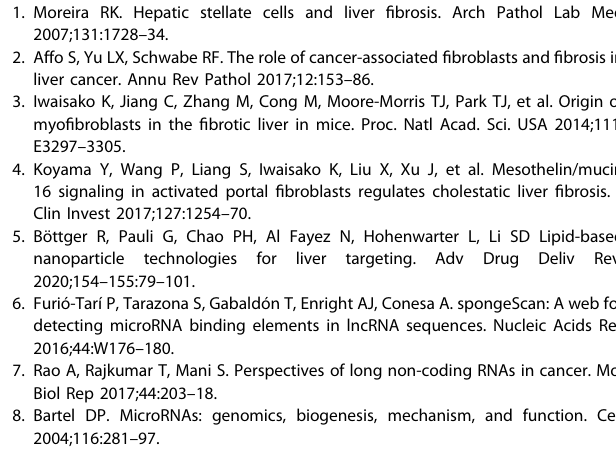
Fig. 8 Downregulation of NEAT1 and overexpression of miR-139-5p suppressed the expression of pro fi brotic markers in murine fi brosis models. A The liver tissues from fi brotic mice injected with Ad-Con or Ad-shNEAT1 were treated with immunohistochemical staining, n = 6 mice for each group, original magni fi cation × 200. B The liver tissues from fi brotic mice injected with agomir control or ago-miR-139-5p were treated with immunohistochemical staining, n = 6 mice for each group, original magni fi cation × 200. C The mRNA expression levels of α -SMA, Collagen-I and TIMP-1 were detected in the liver tissues from the fi brotic mice injected with Ad-Con or Ad-shNEAT1 by qRT-PCR. n = 6/group. D The mRNA expression levels of α -SMA, Collagen-I and TIMP-1 were detected in liver tissues from the fi brotic mice injected with agomir control or ago-miR-139-5p by qRT-PCR. n = 6/group. E The protein levels of β -catenin, SOX9, TGF- β 1, α -SMA, Collagen-I, and TIMP-1 in liver tissues from untreated mice and fi brotic mice transfected with Ad-Con or Ad-shNEAT1 were detected by western blotting. Representative of three experiments. F The protein levels of β -catenin, SOX9, TGF- β 1, α -SMA, Collagen-I, and TIMP-1 in liver tissues from untreated mice and fi brotic mice transfected with the agomir control and ago-miR-139-5p were detected by western blotting. Representative of three experiments. Graph represents mean ± SD. * P < 0.05, ** P <